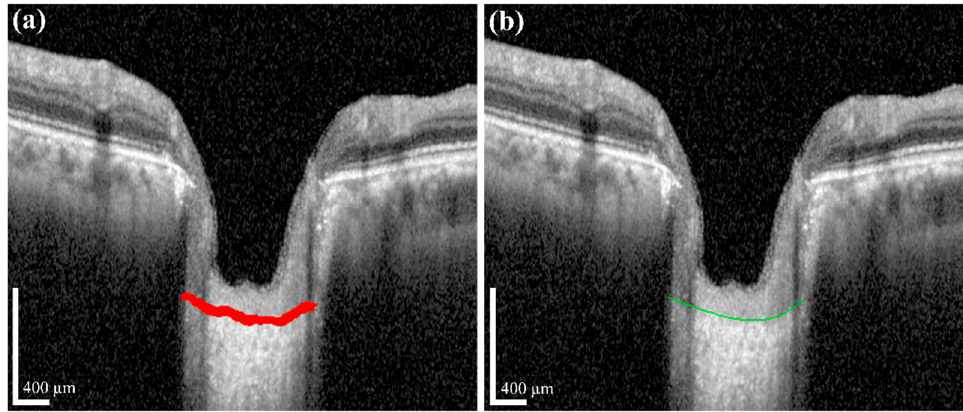
Figure 7. ( a ) Prediction of the anterior LC curve surface (red curve); ( b ) the result after applying the post-processing operation (green curve). Scale bar: 400 µm. the post-processing operation (green curve). Scale bar: 400 µ